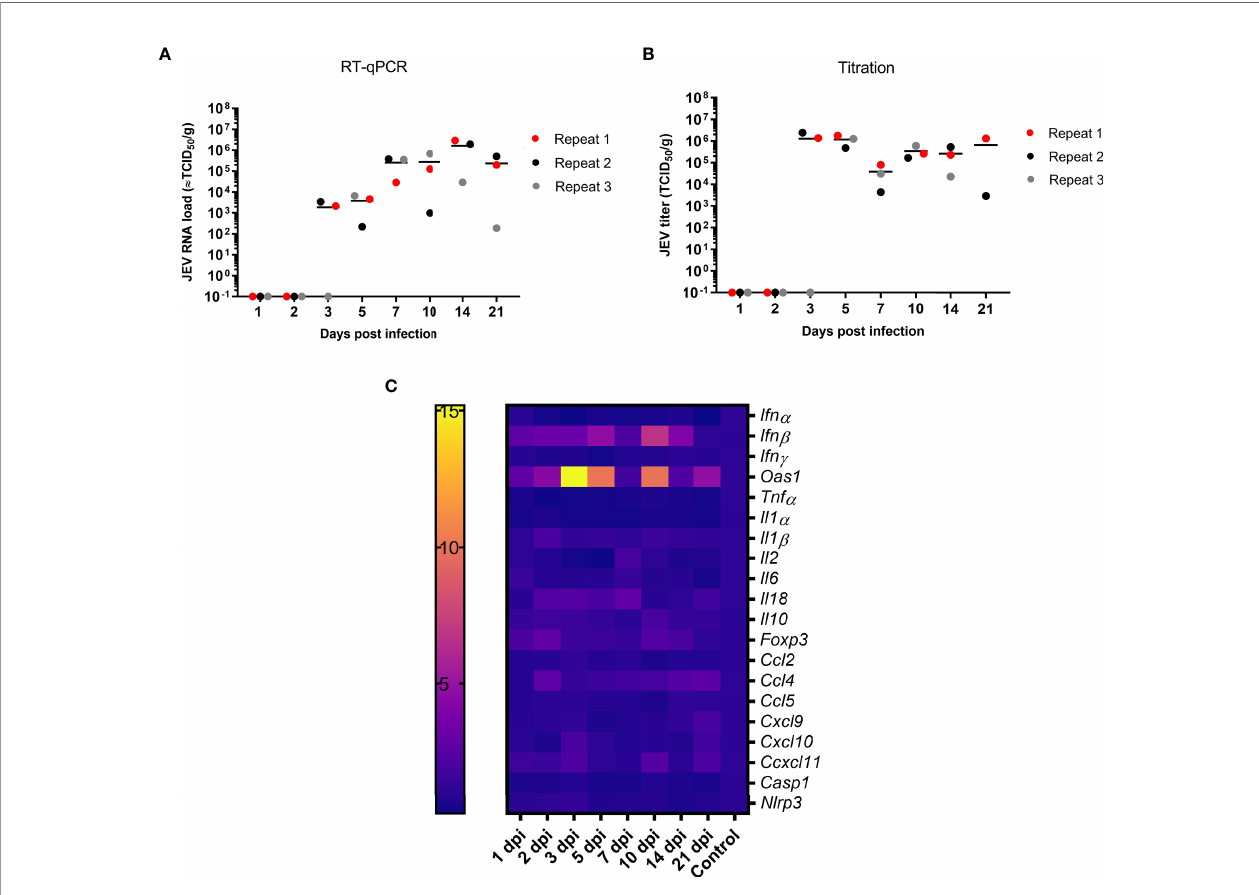
FIGURE 1 | Persistence of JEV in the tonsils. (A) Viral load in the tonsils as determined by RT-qPCR and (B) amount of infectious JEV determined by virus titrations in tonsils of 9-week-old pigs upon intradermal inoculation with 10 5 TCID 50 . Each dot represents one animal. (C) mRNA expression in the tonsil of intradermal inoculated 9-week-old pigs with 10 5 TCID 50 of JEV. Fold changes in IFN a , IFN b , IFN g and OAS1, TNF a , IL1 a , IL2, IL6, IL10, IL18, FOXP3, CCL2, CCL5, CXCL9, CXCL10, CXCL11, NLRP3, and